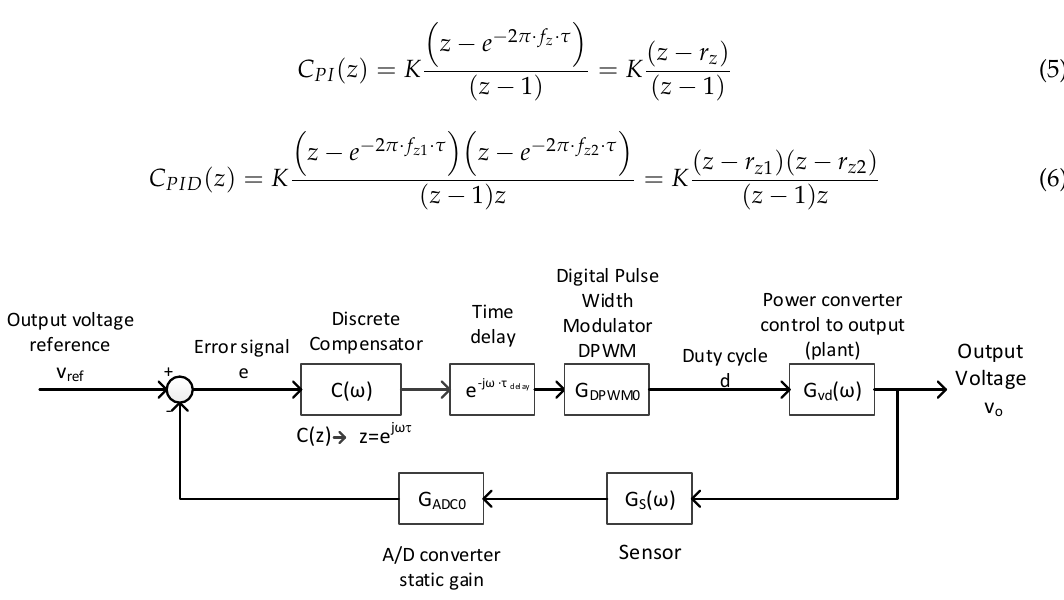
Figure 1. Block diagram of a switched power converter with digital control.